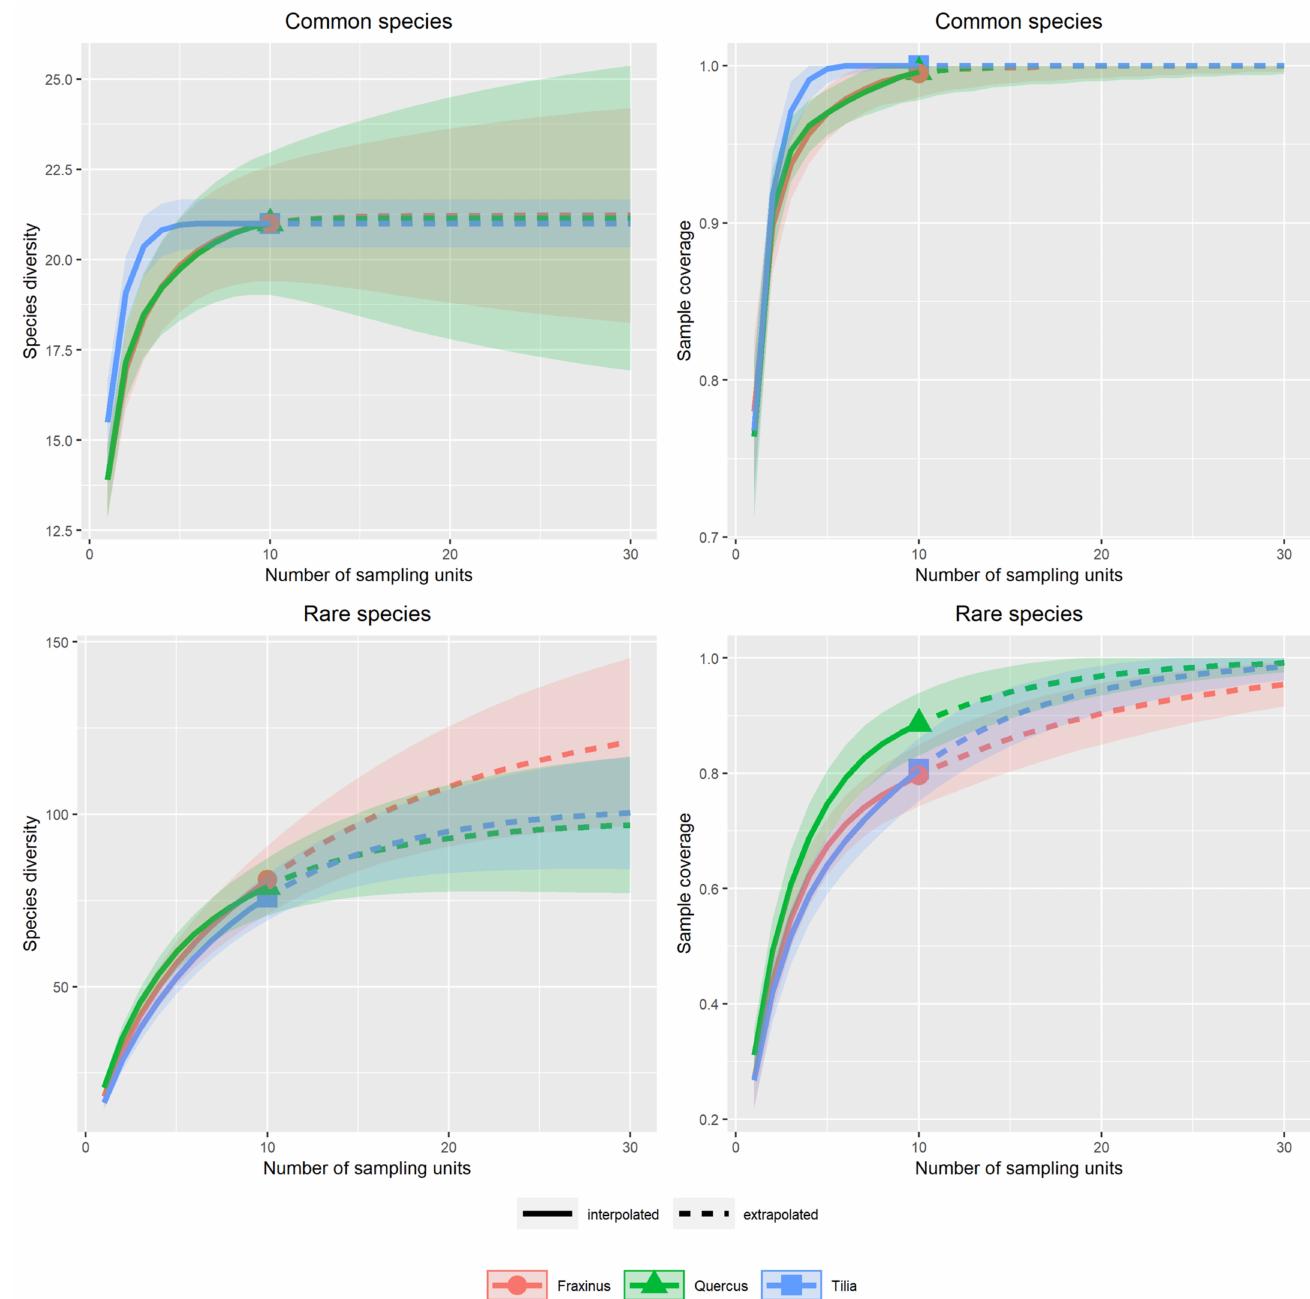
Figure A7. Comparison of species richness and sample coverage among the studied tree species for rare and common beetle species, rarity classification according to the